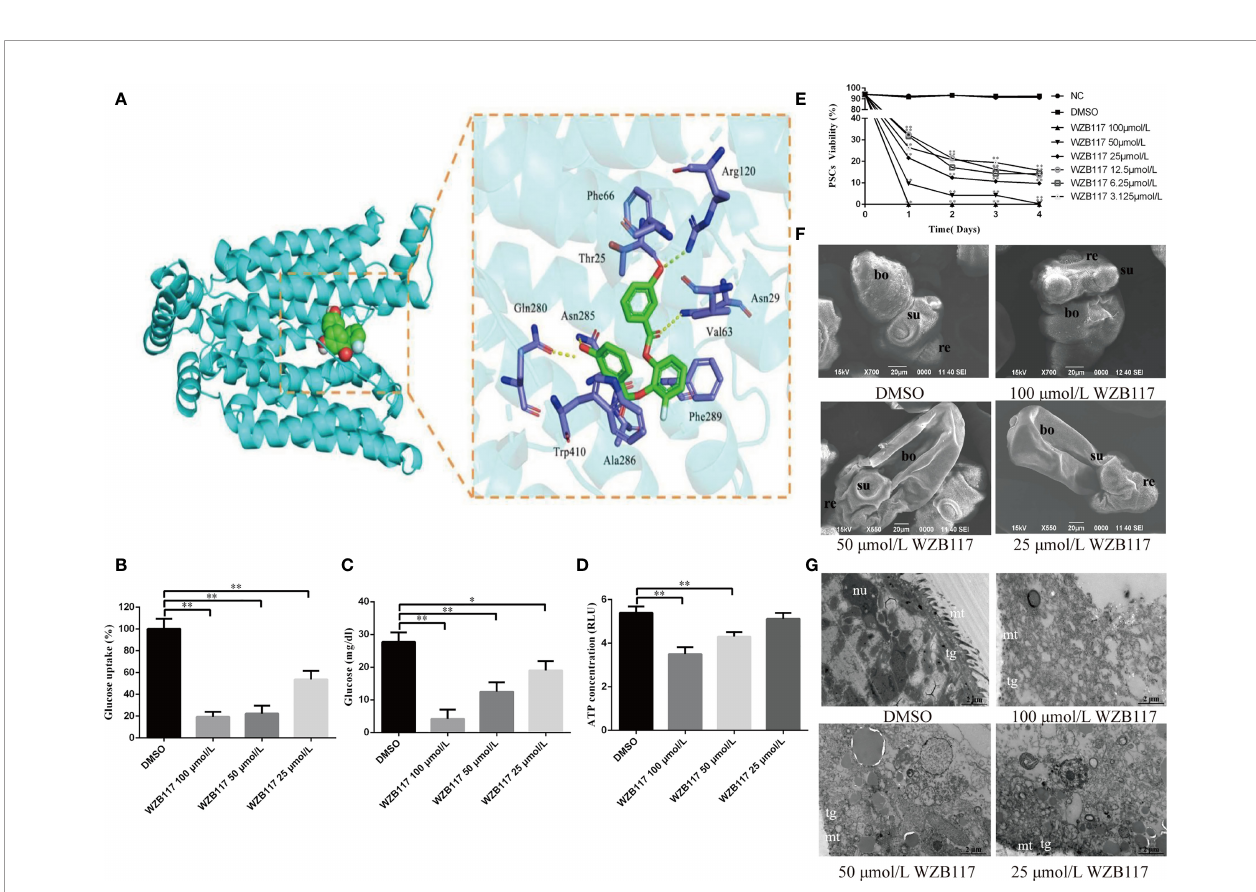
FIGURE 3 | WZB117 inhibits glucose metabolism and reduces the viability of PSCs in vitro . ( A ) Docked structure and interactions of WZB117 binding to EgGLUT1- ss. The image on the left shows that WZB11 binds to the central channel region of EgGLUT1-ss. The image on the right shows the detailed interactions (formation of 4 hydrogen bonds) between WZB117 and amino acid residues of EgGLUT1-ss. (B) Glucose uptake of PSCs after WZB117 incubation for 60 min. (C) Glucose content of PSCs after WZB117 incubation for 48 h. (D) ATP content of PSCs after WZB117 incubation for 48 h. (E) PSCs viability after WZB117 intervention for 4 days. Each point represents the mean percentage of viable PSCs from three different experiments. * and ** show a statistically signi fi cant difference between the treatment group and the DMSO group at the indicated times (* P < 0.05, ** P < 0.01) (chi-square test and one-way ANOVA). Data are the mean ± S.D. of three independent experiments. (F) Representative SEM images of PSCs after WZB117 incubation for 4 days. PSCs incubated in culture medium containing DMSO served as a control. (G) Representative TEM images of PSCs after WZB117 intervention for 4 days. PSCs incubated in culture medium containing DMSO served as a control. NC, negative control group; DMSO, control group; re, rostellum; su, suckers; bo, body; mt, microtriches; nu, nucleus; tg,